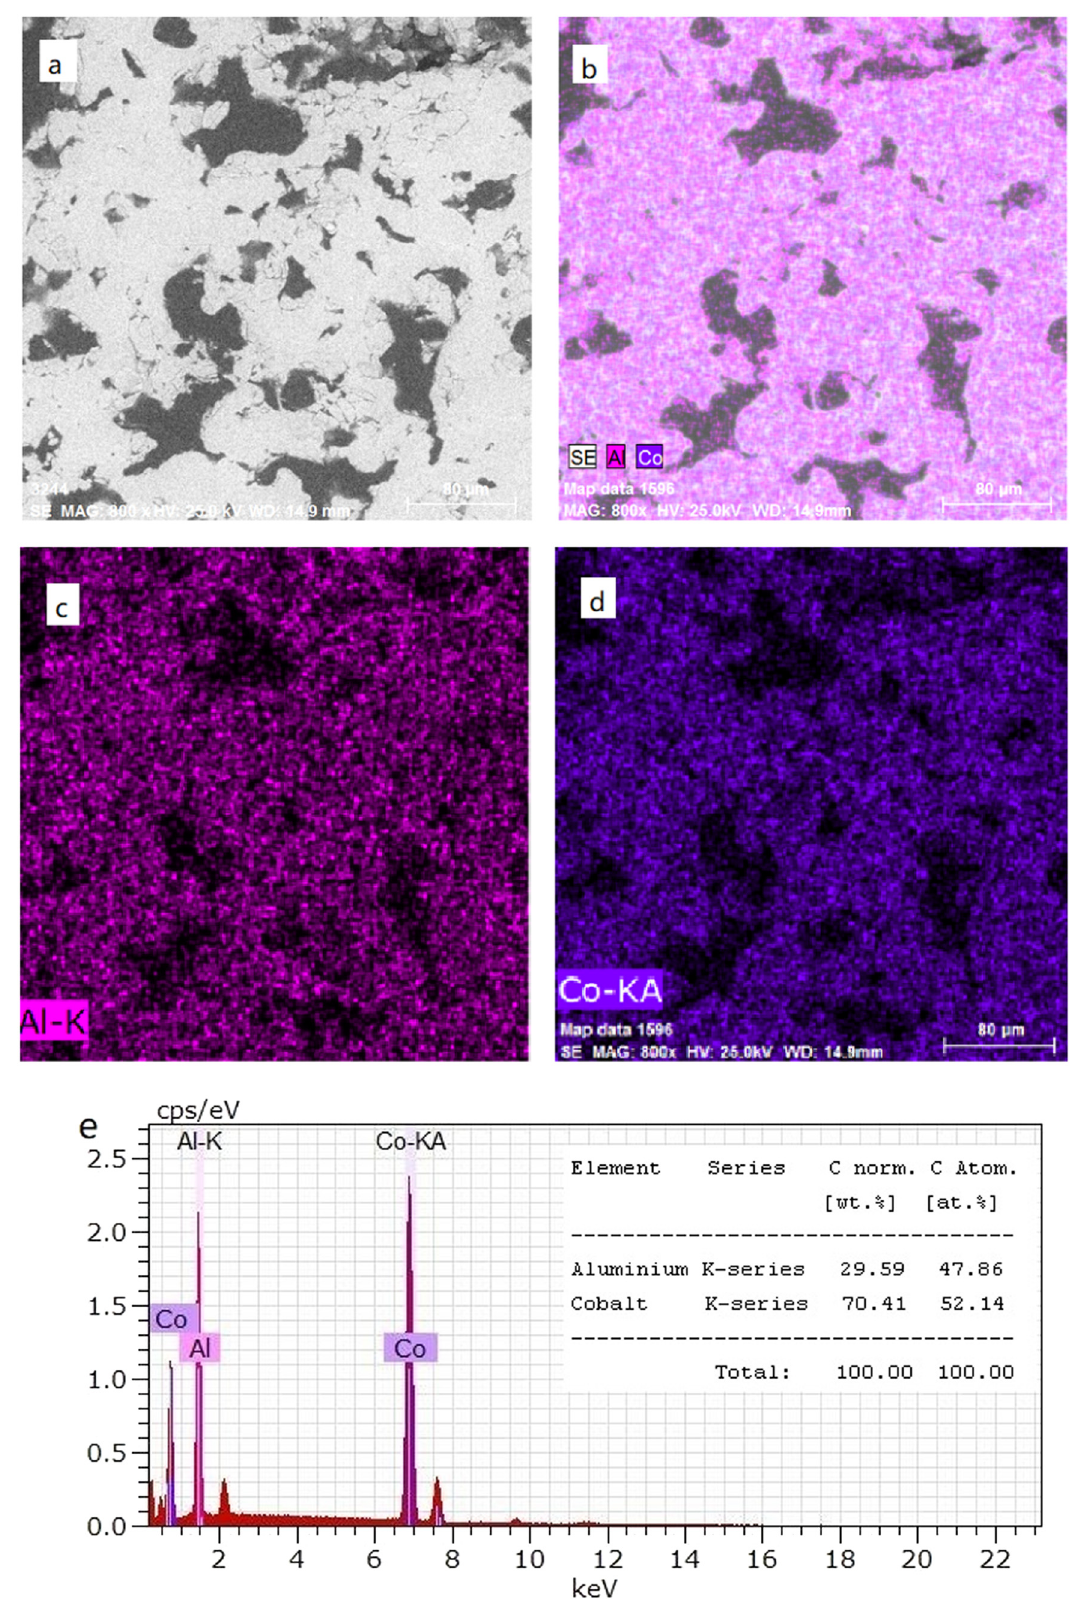
Figure 8: ( a ) SEM images, ( b – d ) elemental mapping and ( e ) EDS analysis of the porous intermetallic compound with Co:Al =